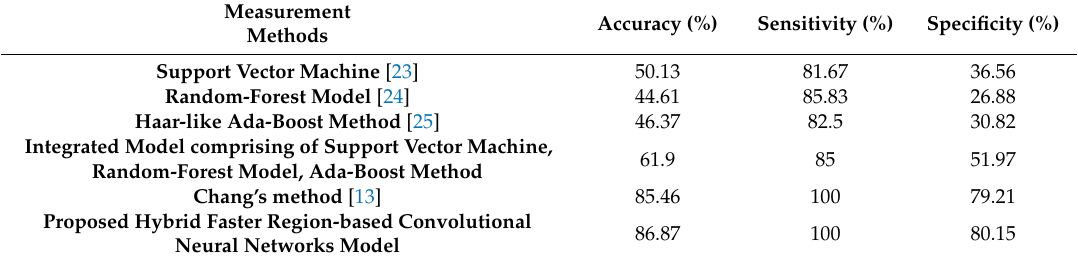
Table 6. Diagnosis of Bubble-defects in Sidewalls of Tire Shearography Images.